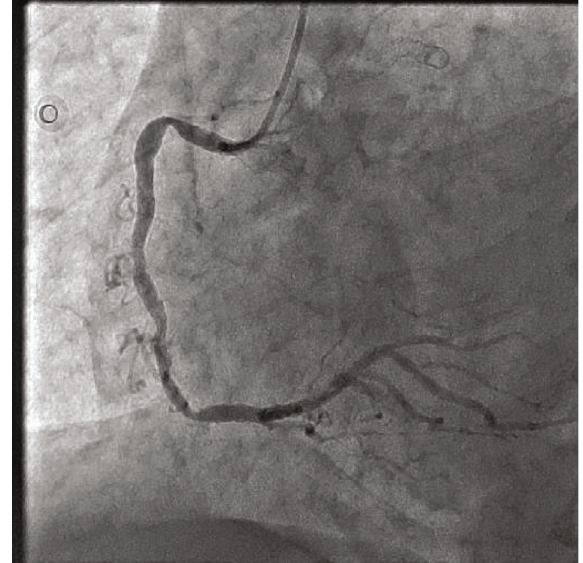
Figure 5: Cardiac catheterization for right coronary artery, dominant artery and showed proximal signi fi cant stenosis, and moderate di ff use stenosis from mid to distal